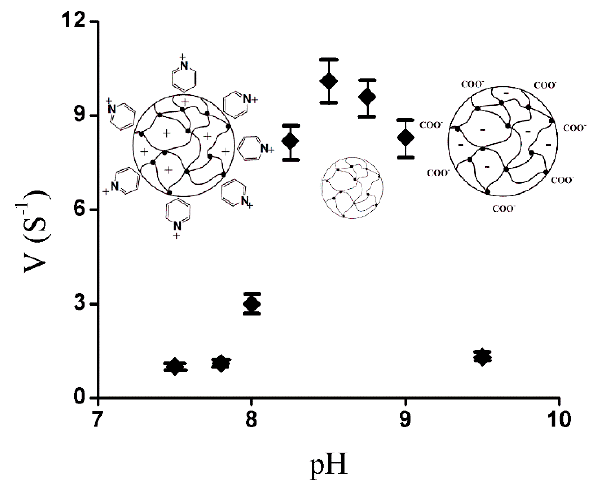
Figure 6. pH effect on the catalytic rate of the imprinted hydrogels in Tris-HCl buffer. Reprinted with permission from Reference 64. Copyright 2010, Wiley.